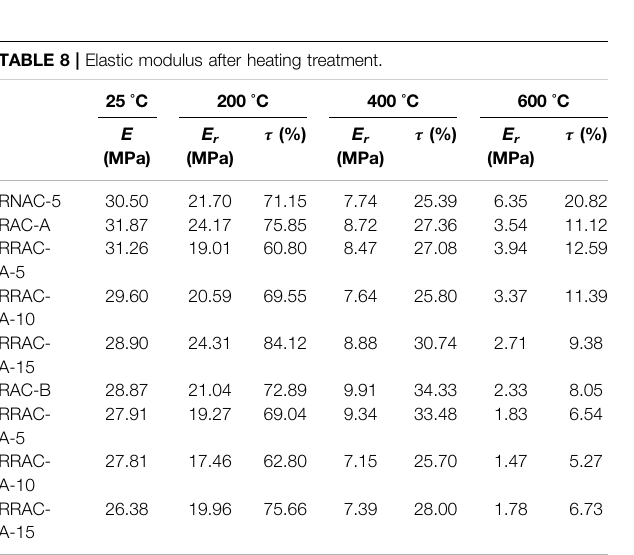
FIGURE 10 | Effect of (A) RA replacement ratio on η ; rubber content on η for (B) RRAC-A and (C) RRAC-B.